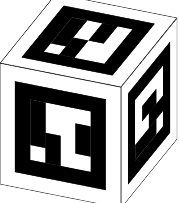
Figure 6: Aruco cube with an MRU placed inside the